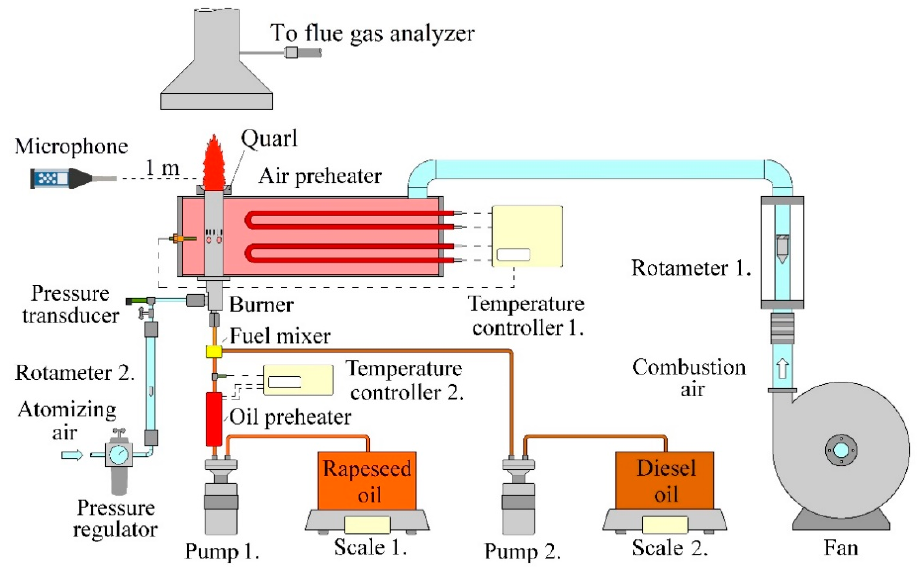
Figure 1. The combustion test rig.